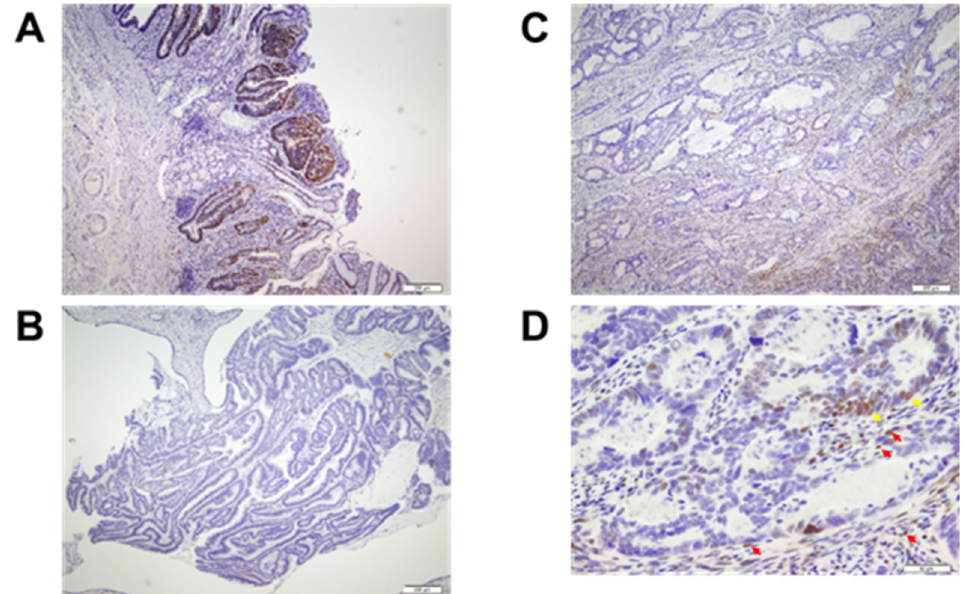
Figure 2 . Immunohistochemical staining with anti-vitamin D receptor (VDR) antibody. Brown cells = VDR+ cells. ( A ) Cancer cells, but not stromal cells, are highly expressing VDR (x 4 0). ( B ) Both cancer cells and stromal cells are not ex- pressing VDR (x 40). ( C ) Both cancer cells and stromal cells are at least in part expressing VDR (x 40). ( D ) A magnified view of a part of panel (x 200). Notice that VDR is expressed mainly in the nuclei of both cancer cells (yellow arrows) and stromal cells (red